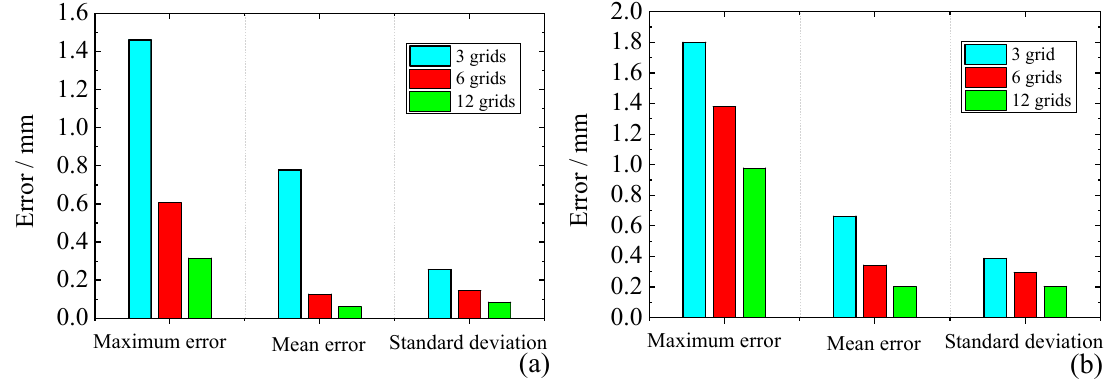
Figure 14. Lifting left outboard ( a ) and inboard ( b ) BB variable grid density results analysis. Table 3. Estimate error of the HKM.